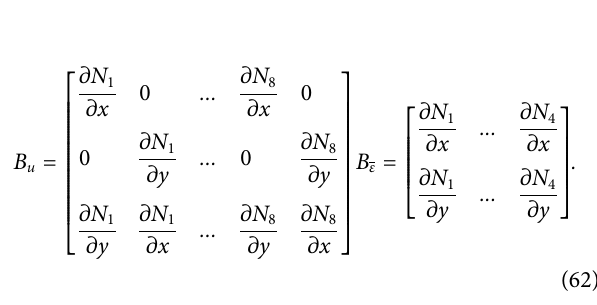
FIGURE 5 | Damage and normalized stress-strain curves for the simulations of different element size.